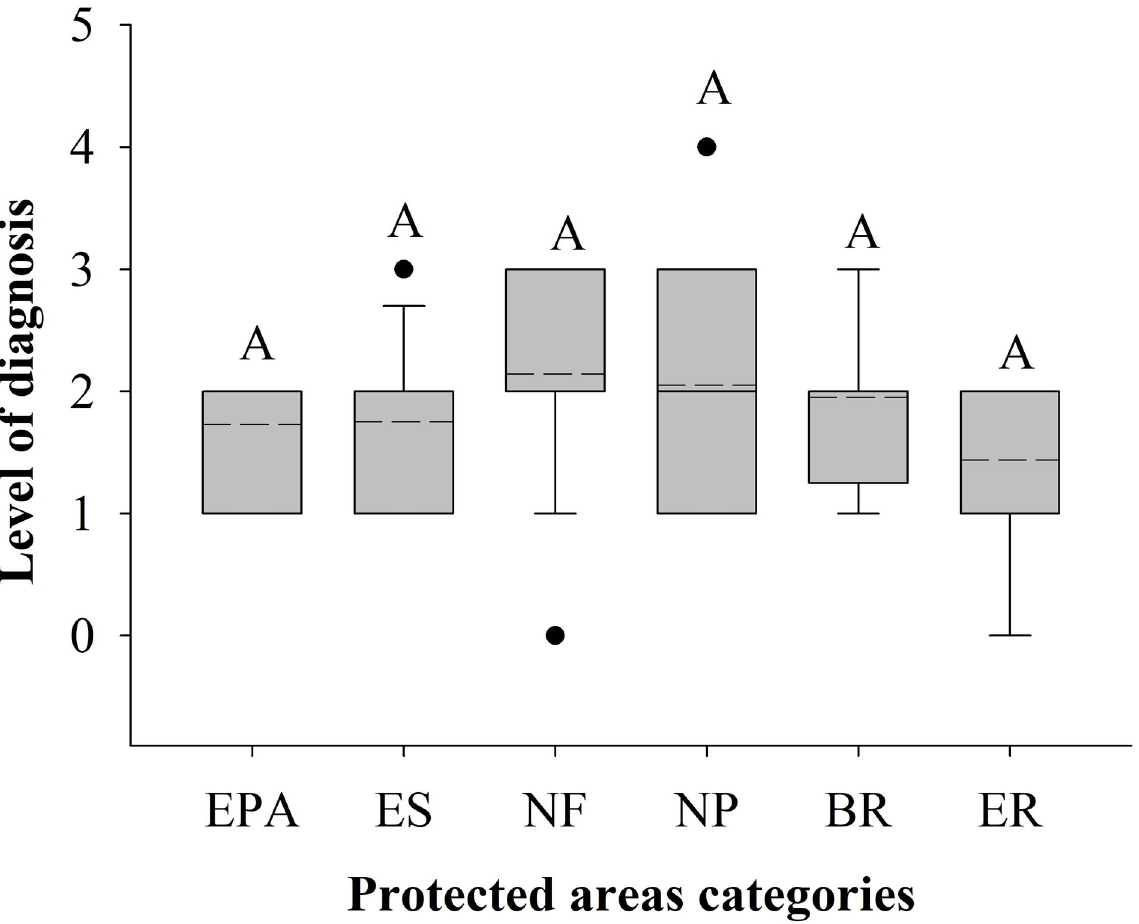
Fig 2. Level of diagnosis of categories of protected areas. Dashed lines represent means. A = values that do not differ statistically (H = 10.51; GL = 5; p = 0.061). Categories: EPA–Environmental Protection Areas, ES–Ecological Stations, NF–National Forests, NP–National Parks, BR– Biological Reserves, ER–Extractive Reserves.